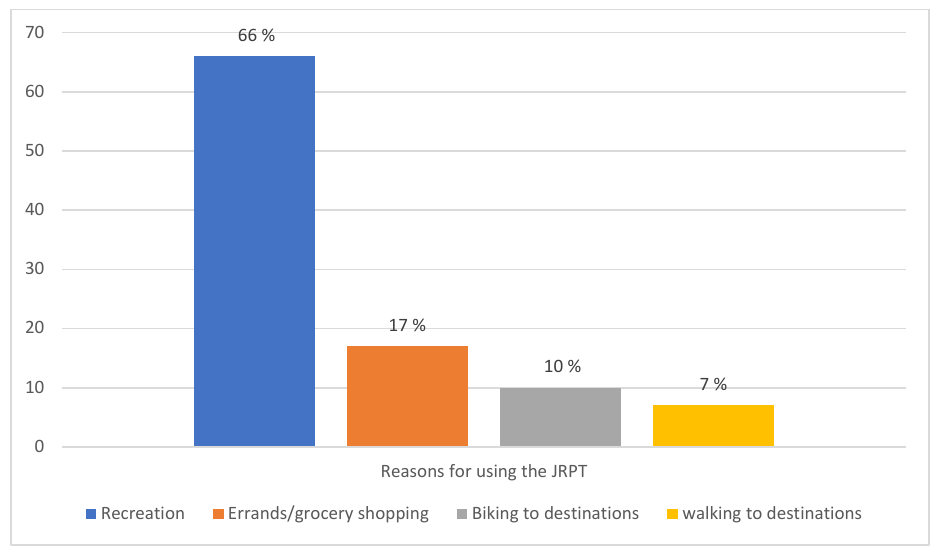
Figure 3. Active and public transportation users by objective. source: created by authors for this paper. What this information indicates is that the purpose of both corridors appears to have some overlap.